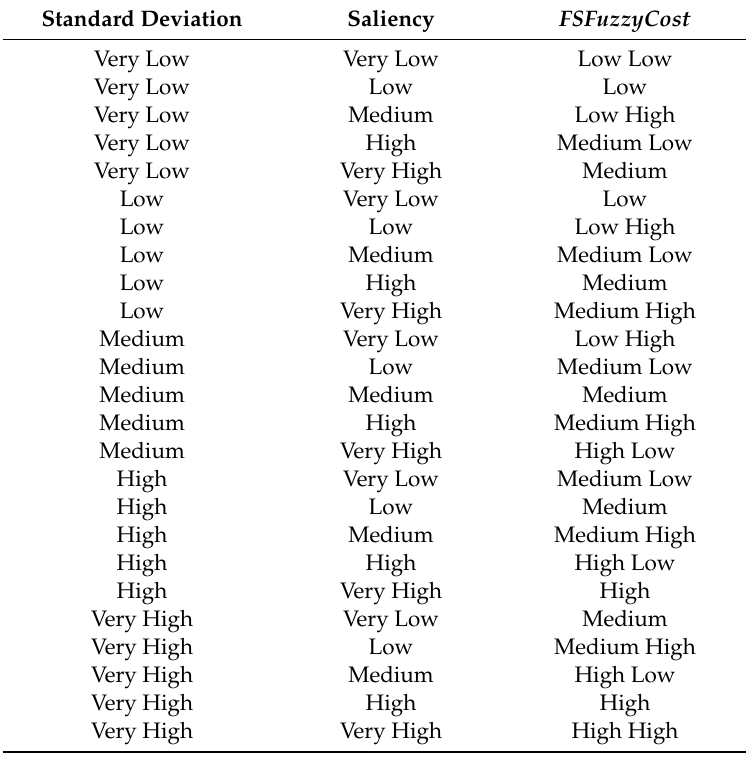
Table 2. Fuzzy rules regarding the fuzzy cost for feature